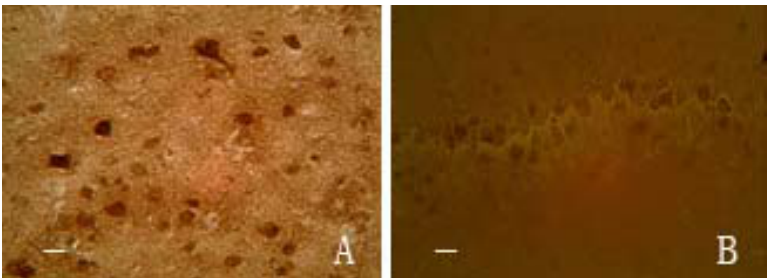
Figure 2. The expressions of NSE in cortex ( A ) and S-100 in hippocampus ( B ). The immunochemical positive cells showed brown granules in cytoplasm, bar 25